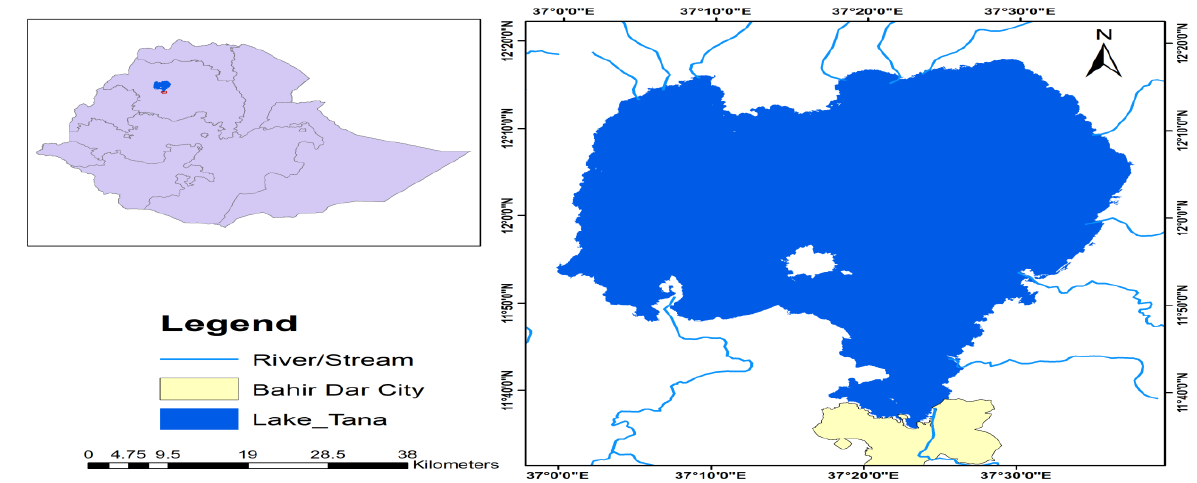
Figure 1. A map showing the sampling site of Nile tilapia in Ethiopia.